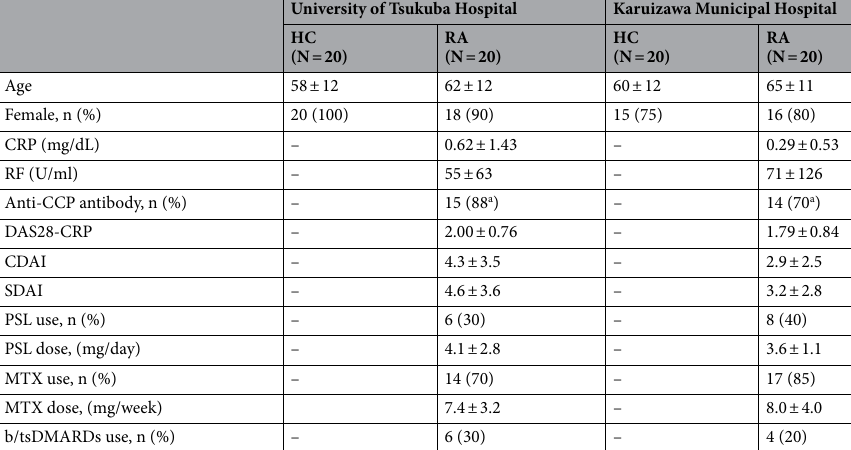
Table 1. Demographics and clinical characteristics of HCs and RA patients. Anti-CCP antibody, anti-cyclic citrullinated peptide antibody; b/tsDMARDs, biologic or targeted synthesized disease modifying anti- rheumatic drugs; CDAI, Clinical Disease Activity Index; CRP, C-reactive protein; MTX, methotrexate; PSL, prednisolone; RF, rheumatoid factor; SDAI, Simplified Disease Activity Index. Continuous variables are showed by Mean ± standard deviation (SD). a Anti-CCP antibody was measured in 20 RA patients from the University of Tsukuba Hospital and Karuizawa Municipal Hospital, respectively (N =